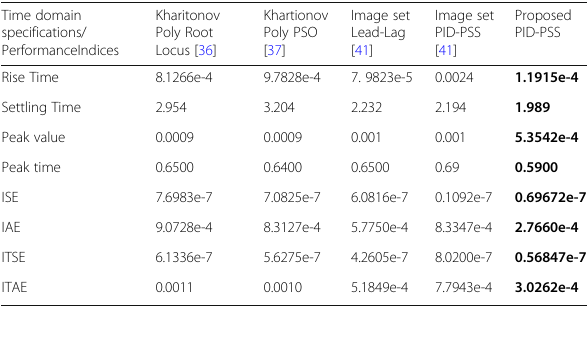
Table 7 Comparision of performance measures between the proposed and existing methods at P = 0.8 p.u . and Q = 0.3 p.u Time domain specifications/